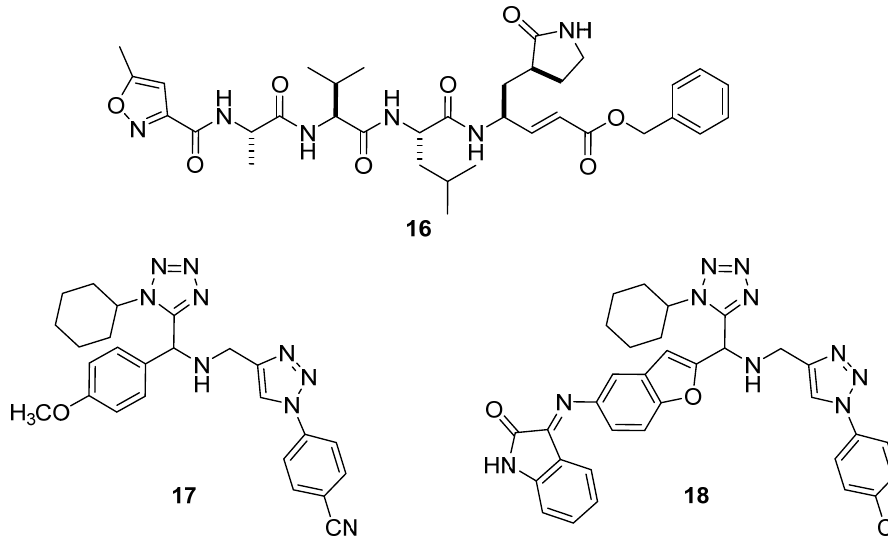
Figure 3. Structures of N3 inhibitor 16 , 1,5-disubstituted tetrazole-1,2,3-triazoles 17 and 18 .